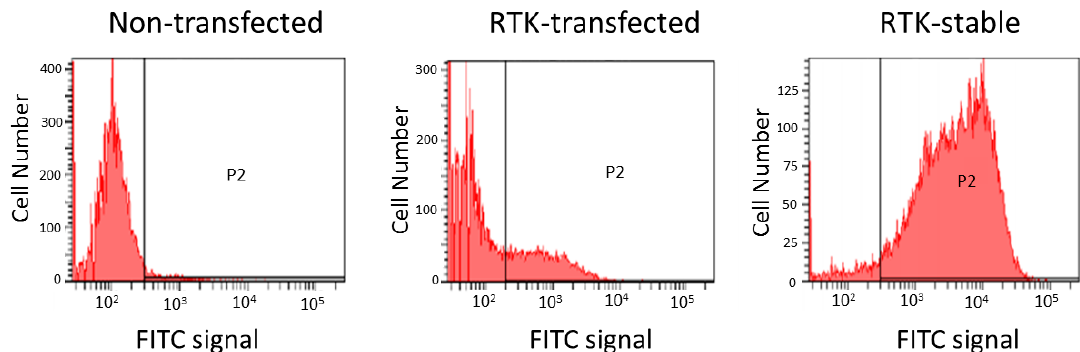
Figure 5. Cell surface expression in transiently-transfected or stably transfected cells. Human embryonic kidney 293 (HEK-293) cells were transiently transfected with an expression vector for a receptor tyrosine kinase (RTK) using a cationic lipid transfection reagent. Twenty-four hours post-transfection, the cells were stained with an anti-RTK monoclonal antibody and fluorescein isothiocyanate (FITC)-labeled anti-mouse antibody and analyzed by fluorescence-activated cell sorting (FACS). The FITC signal for the transfected cells was compared to non-transfected cells or cells stably transfected to express the target RTK. The percentage of FITC-positive cells was 94% for the stable cell line versus 27% for the transfected cells.